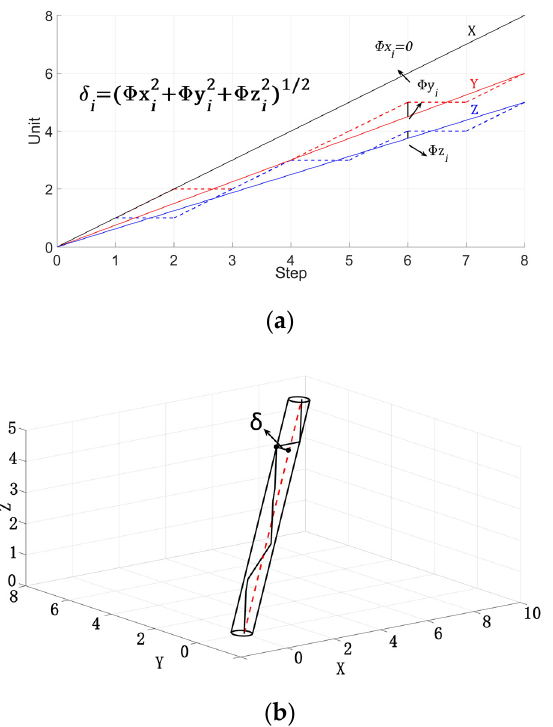
Figure 12. Results of the spatial straight-line algorithm. ( a ) The motion process of each axis. ( b ) Spatial straight line and straightness